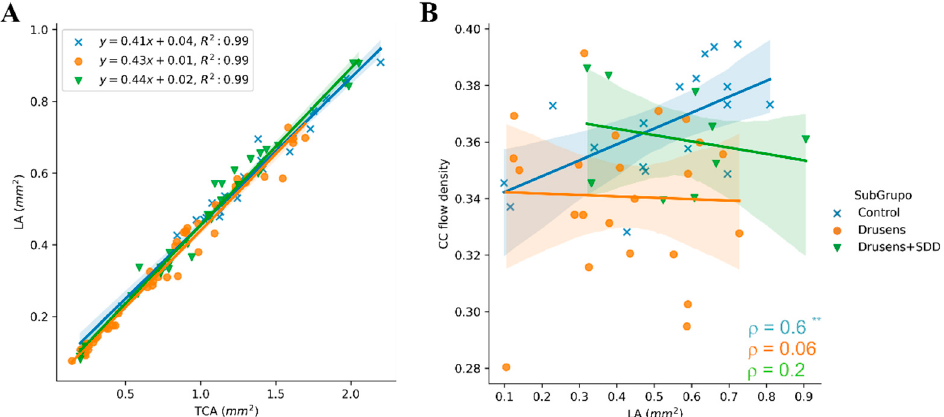
Figure 5. Correlation analysis with ( A ) Scatter plots with linear regression lines and coefficient of determination (R-squared) calculated for the total choroidal area and luminal area among control, 1A (Drusens) and 1B (Drusens + SDD) groups. Linear regression lines (blue-control; orange—group 1A and green-group 1B) were calculated and represented using stats’ linregress and seaborn’s lmplot functions, respectively. Light blue-, orange-, and green-coloured regions indicate the 95% confidence interval for each regression line; ( B ) Correlation scatter plots between choriocapillary (CC) flow density and luminal area (LA) (mm 2 ) in control, 1A (Drusens) and 1B (Drusens + SDD) groups. Best-fitted lines (blue-control; orange—group 1A and green-group 1B) were represented and visualized through seaborn’s lmplot function. Light blue-, orange-, and green-coloured regions indicate the 95% confidence interval for each regression line. Spearman’s rank correlation coefficient ( ρ ) for each group is in the lower right corner. The correlation coefficients were: 0.6 (control), − 0.06 (group 1A) and − 0.2 (group 1B). The asterisks represent the p -value of the statistical test: ** p -value < 0.01.